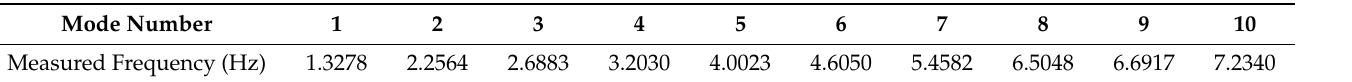
Table 1. Measured frequencies of the cable network with hinged-end support determined by ABAQUS.